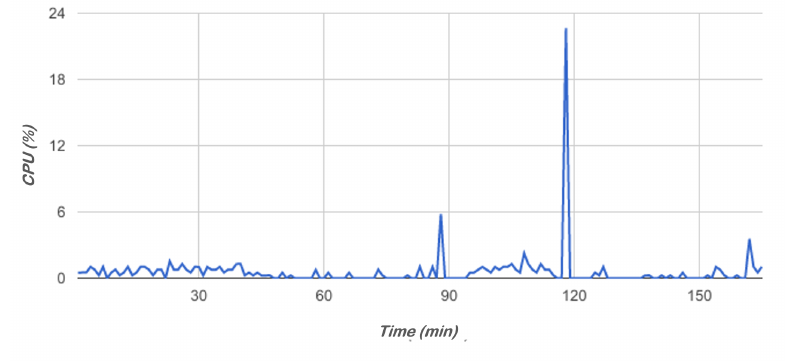
Figure 13. System CPU usage over time.